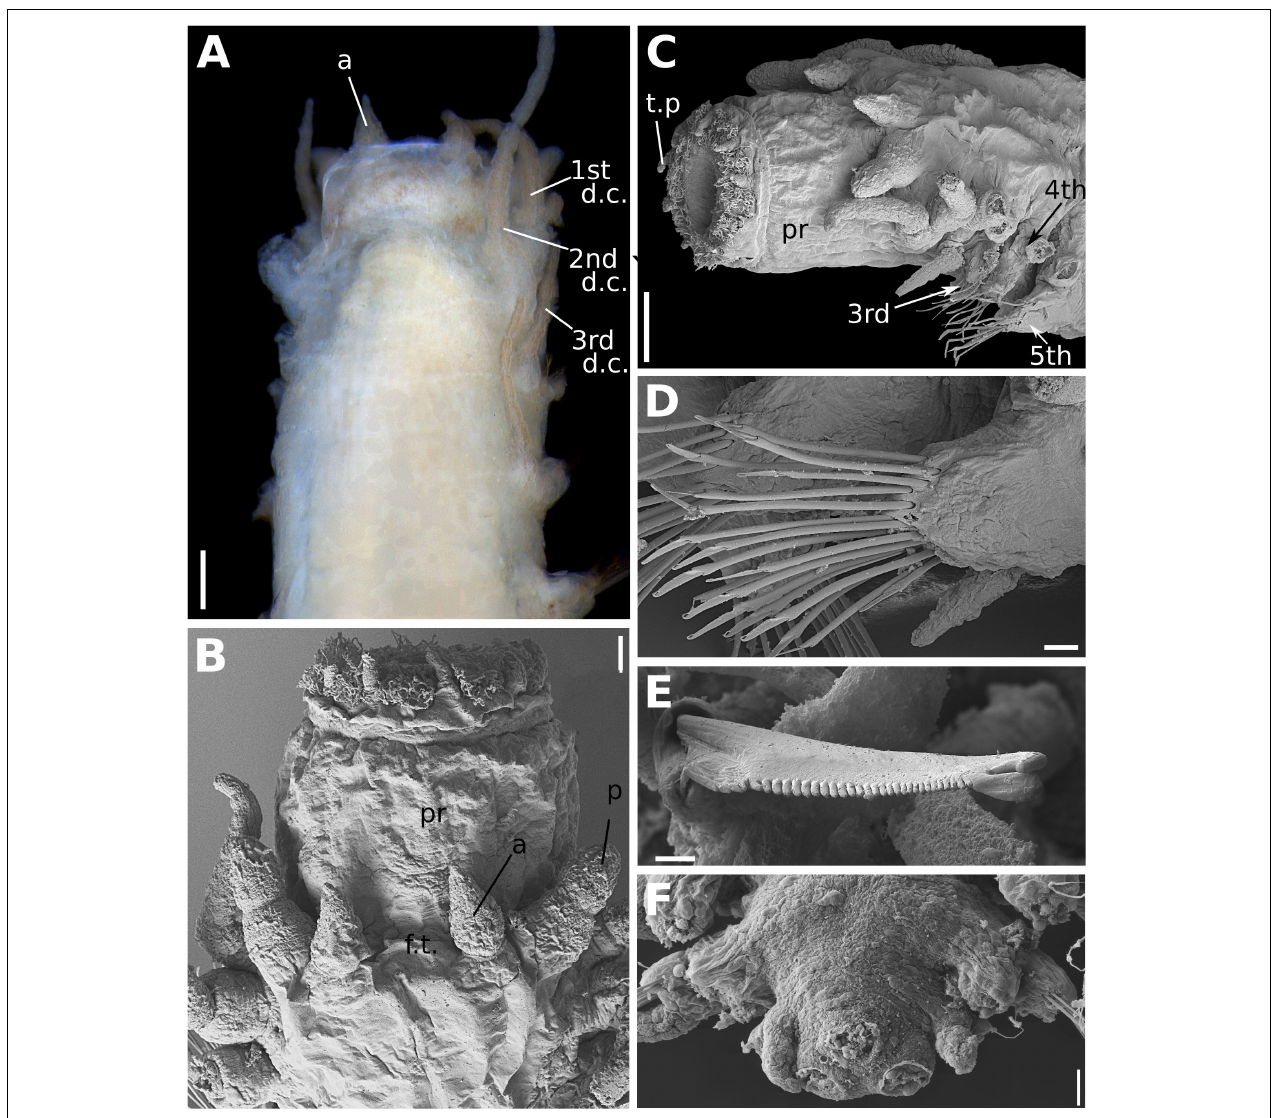
FIGURE 8 | (A–F) Sirsoe alphacrucis sp. nov. (A) anterior end, dorsal view; (B) anterior end, dorsal view; (C) anterior end, lateral view; (D) median neuropodia; (E) detail of neurochaeta; (F) posterior end, dorsal view, showing the insertions of pygidial cirri and papilla. 1st d.c., first dorsal cirrus; 2nd d.c., second dorsal cirrus; 3rd d.c., third dorsal cirrus; a, lateral antenna; ci, ciliation; c.v, ventral cirri; p, palp: pr, proboscis; t.p, terminal papilla. Numbers in (C) referring to the segment. Scales: (A) 100 µ m; (B) 30 µ m; (C,D,F) 20 µ m; (E) 2 µ